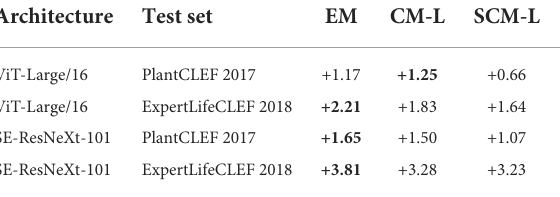
TABLE 6 Accuracy before and after prior shift adaptation with the EM algorithm (Saerens et al., 2002) and the (S)CM-L methods (Sipka et al., 2022) on the ExpertLifeCLEF 2018 and the PlantCLEF 2017 test sets.